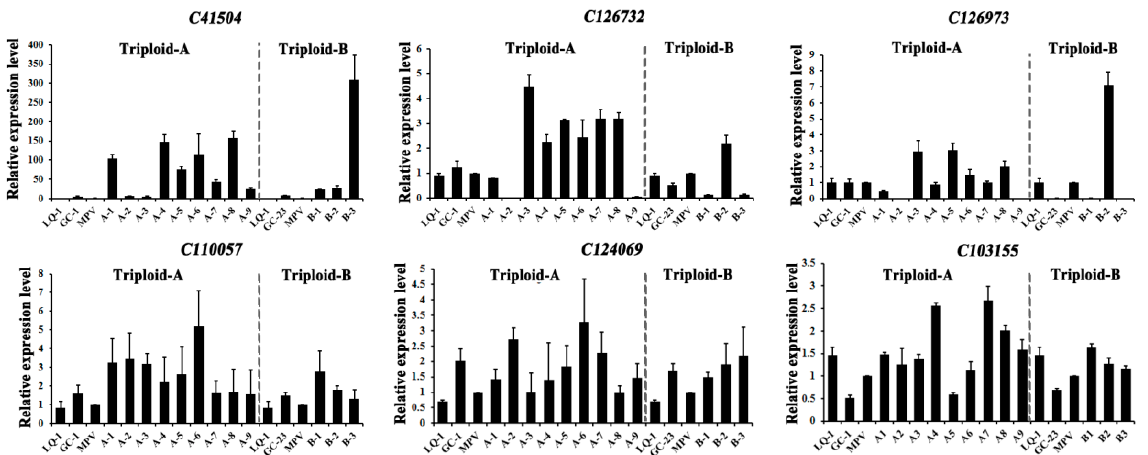
Table 3. The expression patterns of the selected DEGs in triploid loquat.